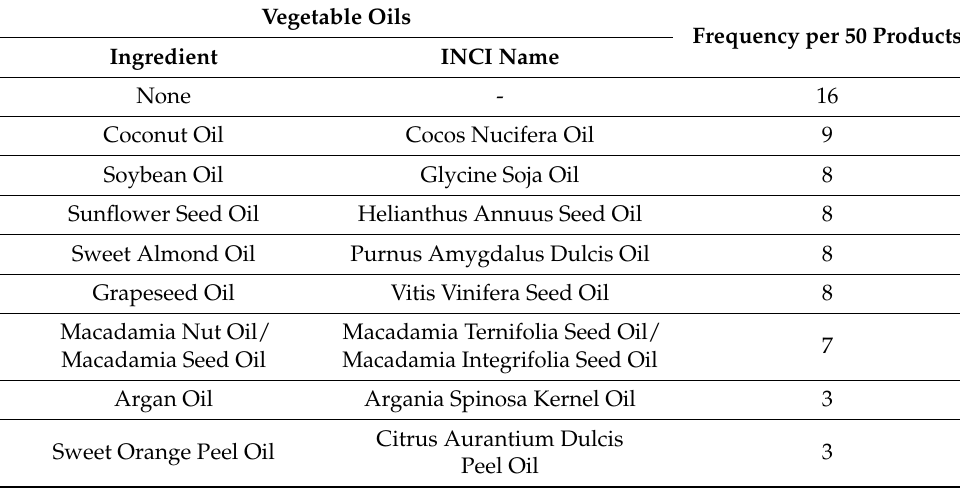
Table 4. Frequency of vegetable oils in analyzed cosmetic